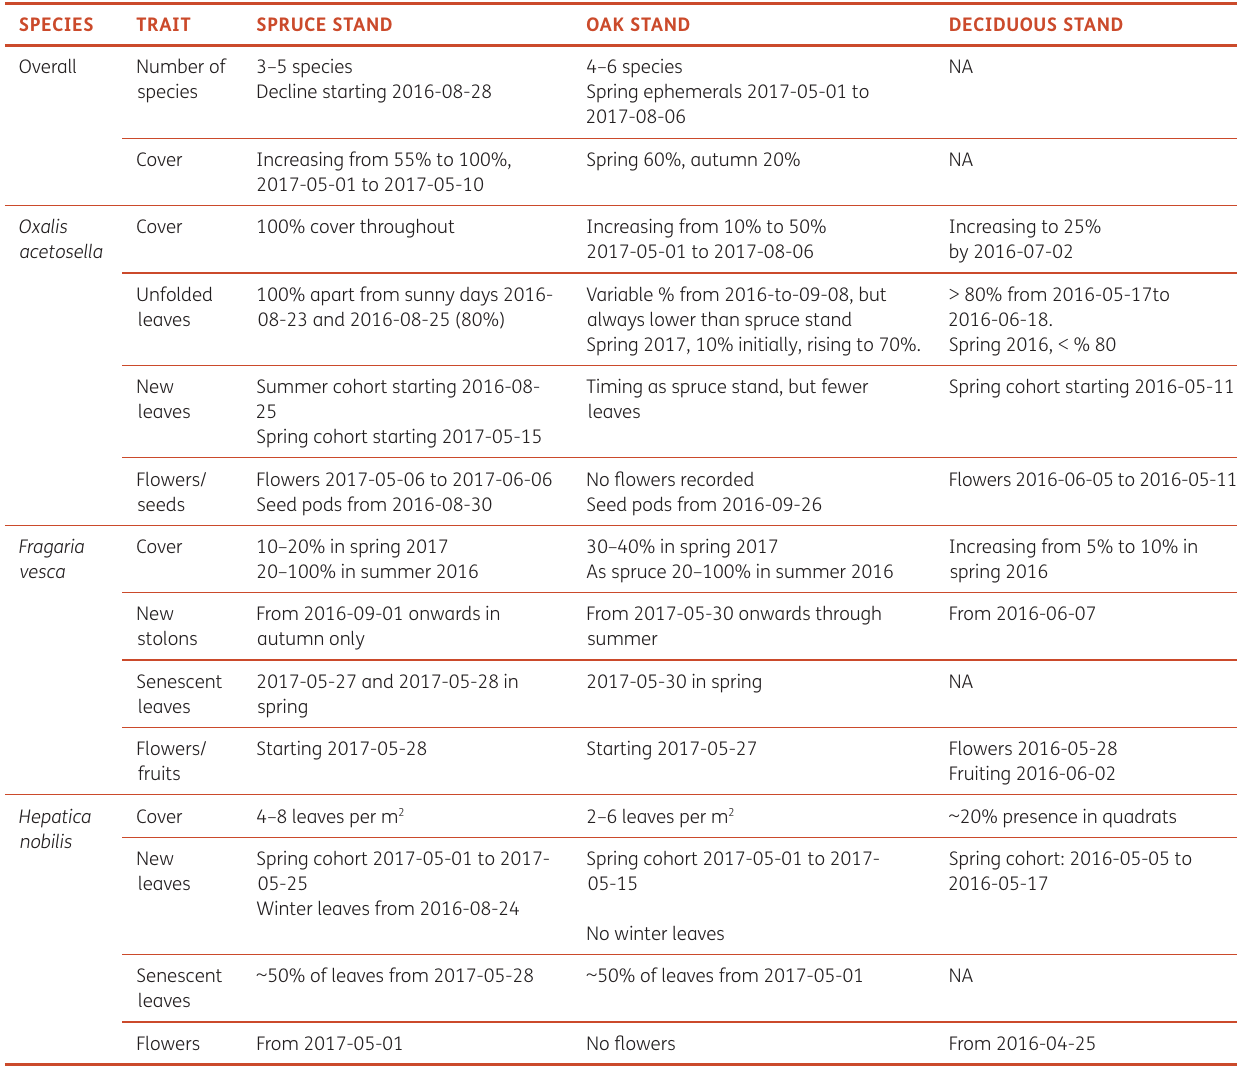
Table 1 Results of the vegetation survey activity on the main understorey species from quadrats in spruce and oak stands, and from researcher-collected data at the deciduous stand level. Full data are given and presented graphically in the supplemental